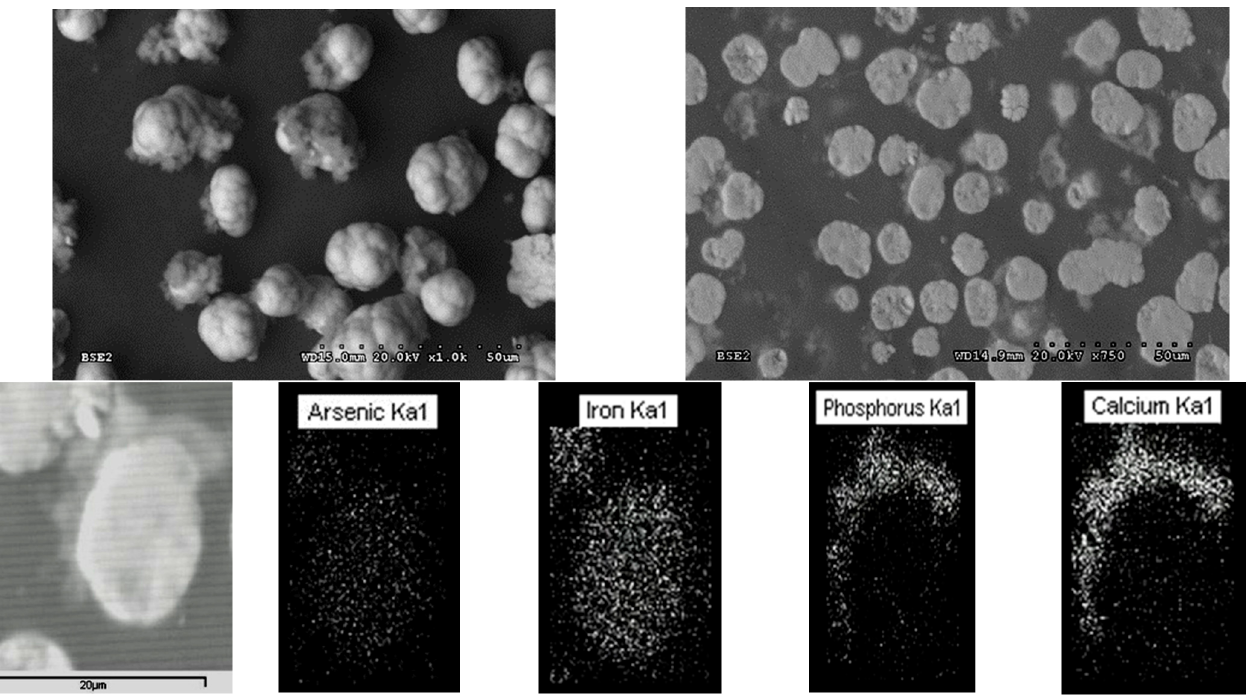
Figure 6. SEM images of resulting scorodite@HAP solids from encapsulation method C (ENCH-C) (top); and backscattered electron image of a partially coated scorodite particle’s cross-section along its elemental maps revealing its coating with HAP.